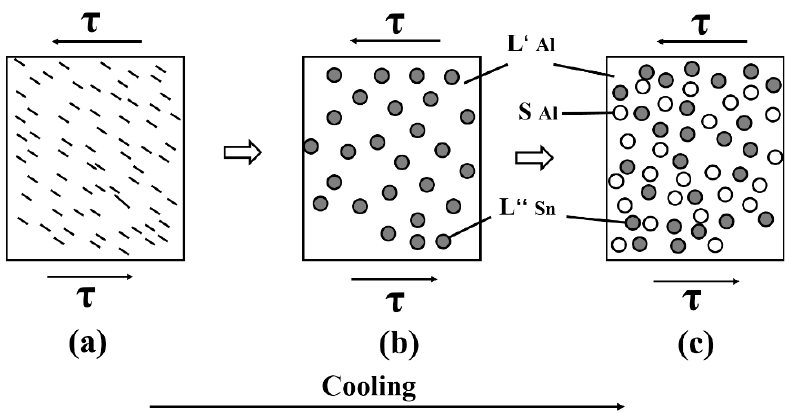
Figure 6. Schematic of the rheomixing process to achieve fine and homogeneous microstructure in immiscible alloys , ( a ) homogeneous liquid (above the Tc ); ( b ) creation of the L ′′ droplets in L ′ ; ( c ) rheomixing: formation of a primary α -Al solid phase (S) in L ′ through a monotectic reaction. Reprinted with permission from Ref. [99]. Copyright 2009 Springer Nature Customer Service Centre GmbH, Springer Nature.